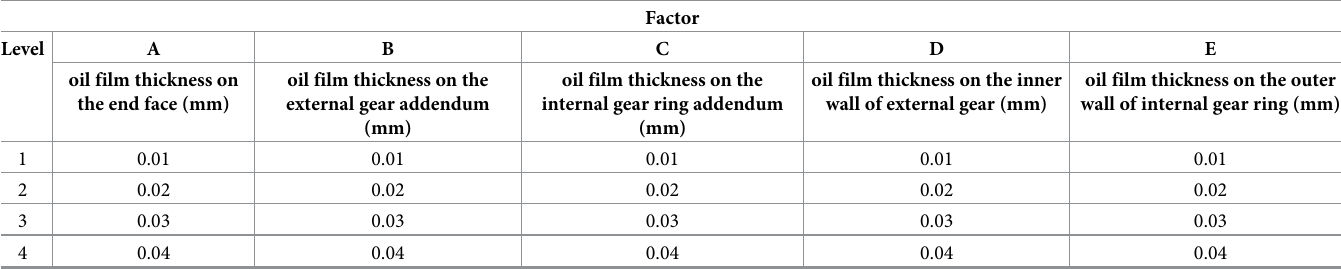
orthogonal table L (4 5 ) is selected. The 16 specific test conditions can be procured, and the 16 corresponding test schemes are shown in Table 2.